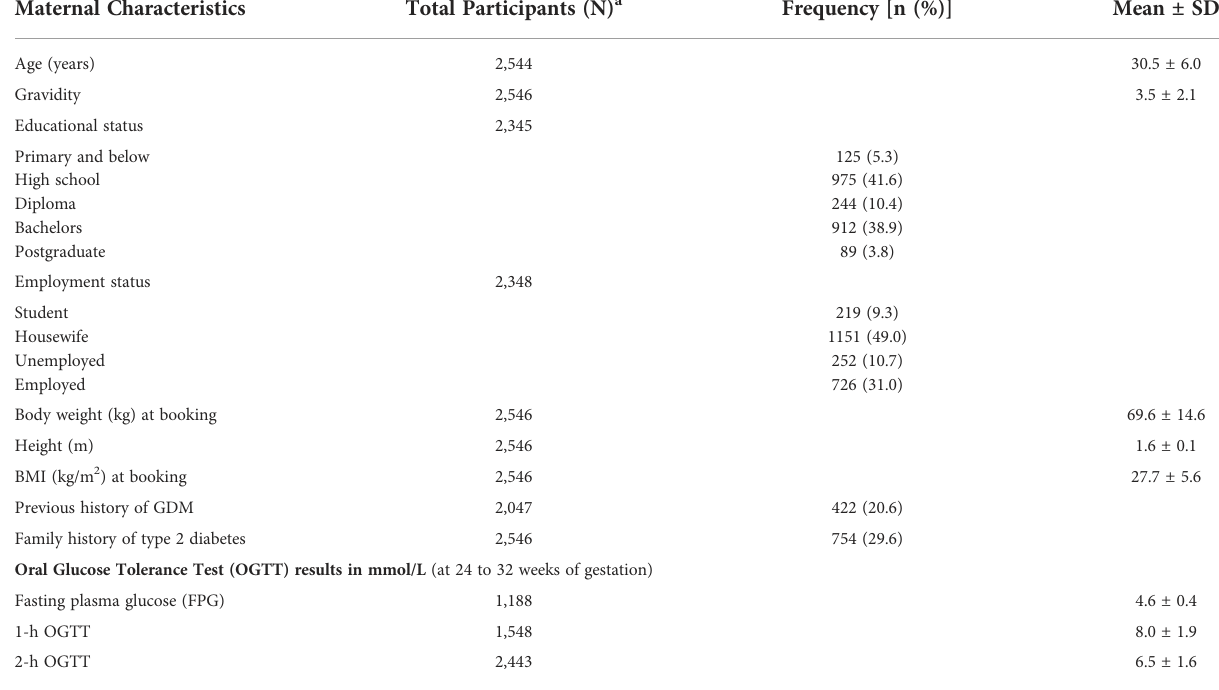
TABLE 2 Baseline characteristics of participants (N =